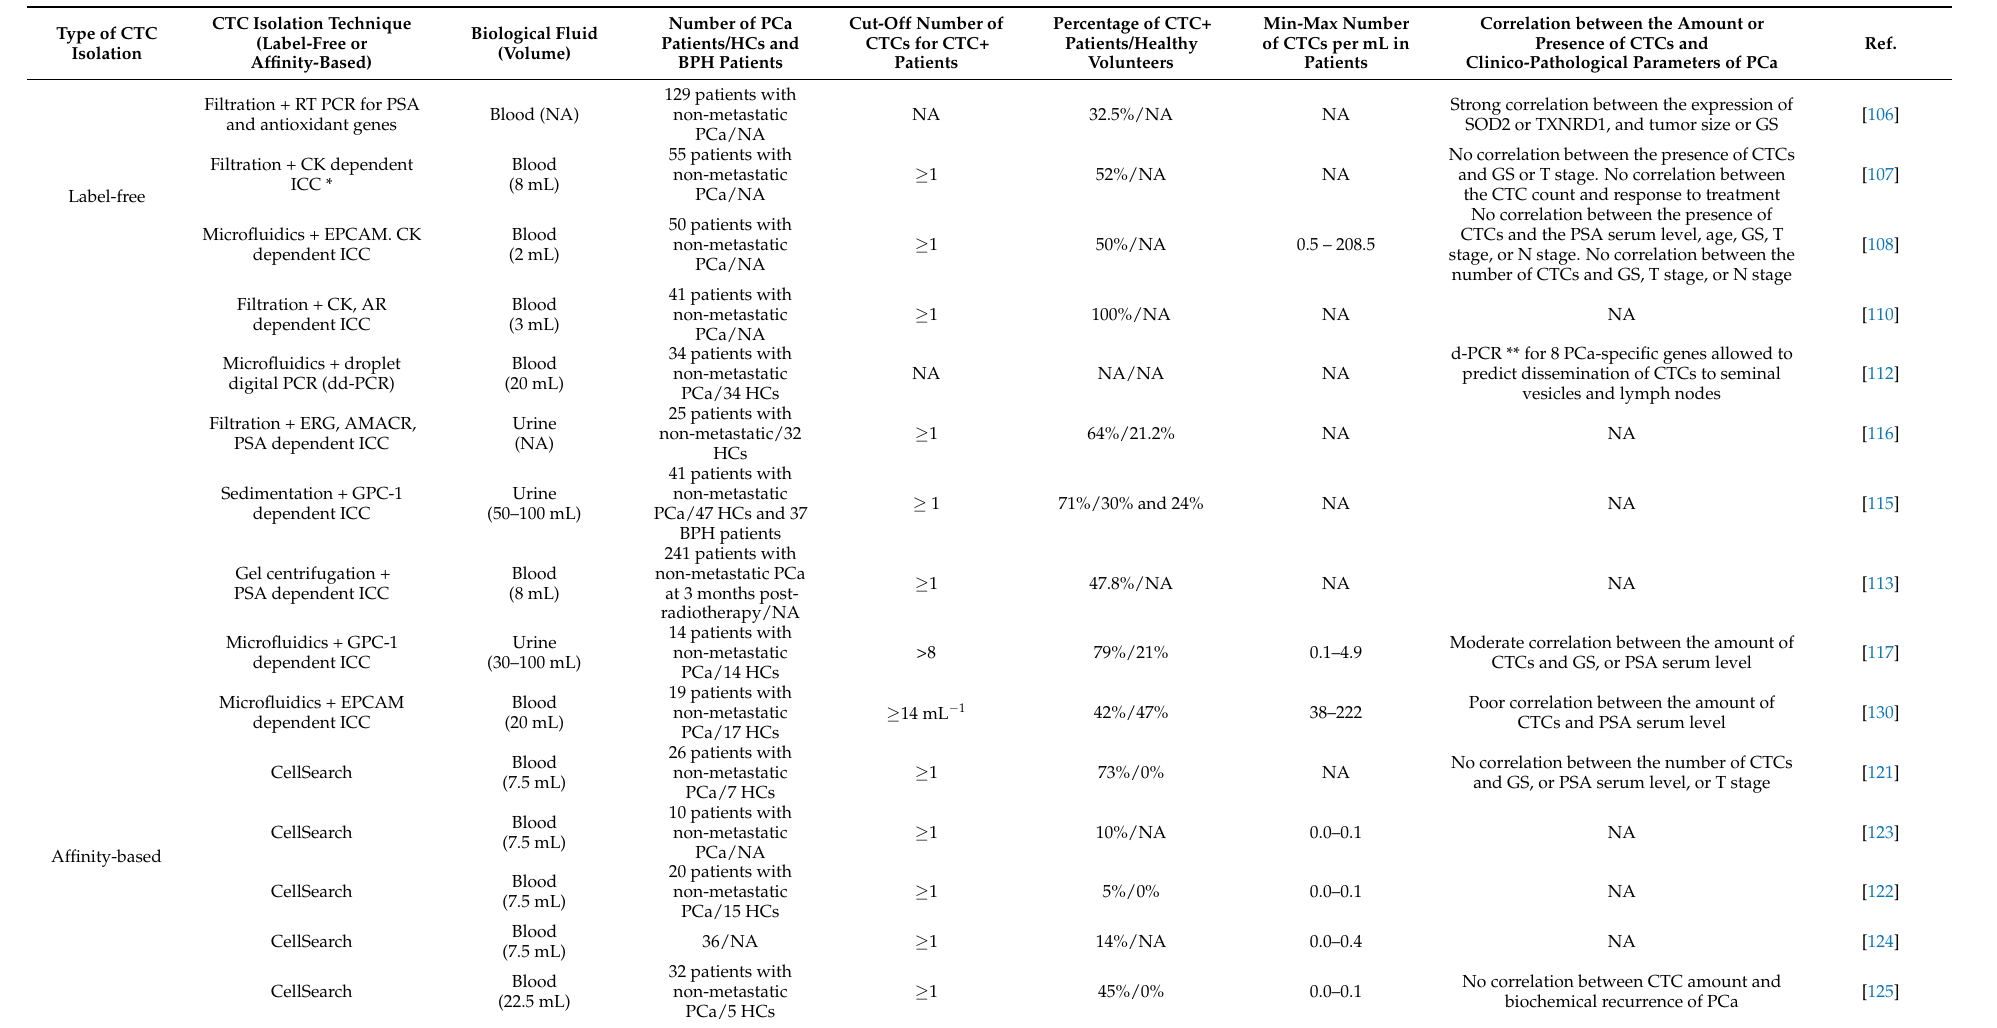
Table 2. Circulating tumor cells in patients with non-metastatic